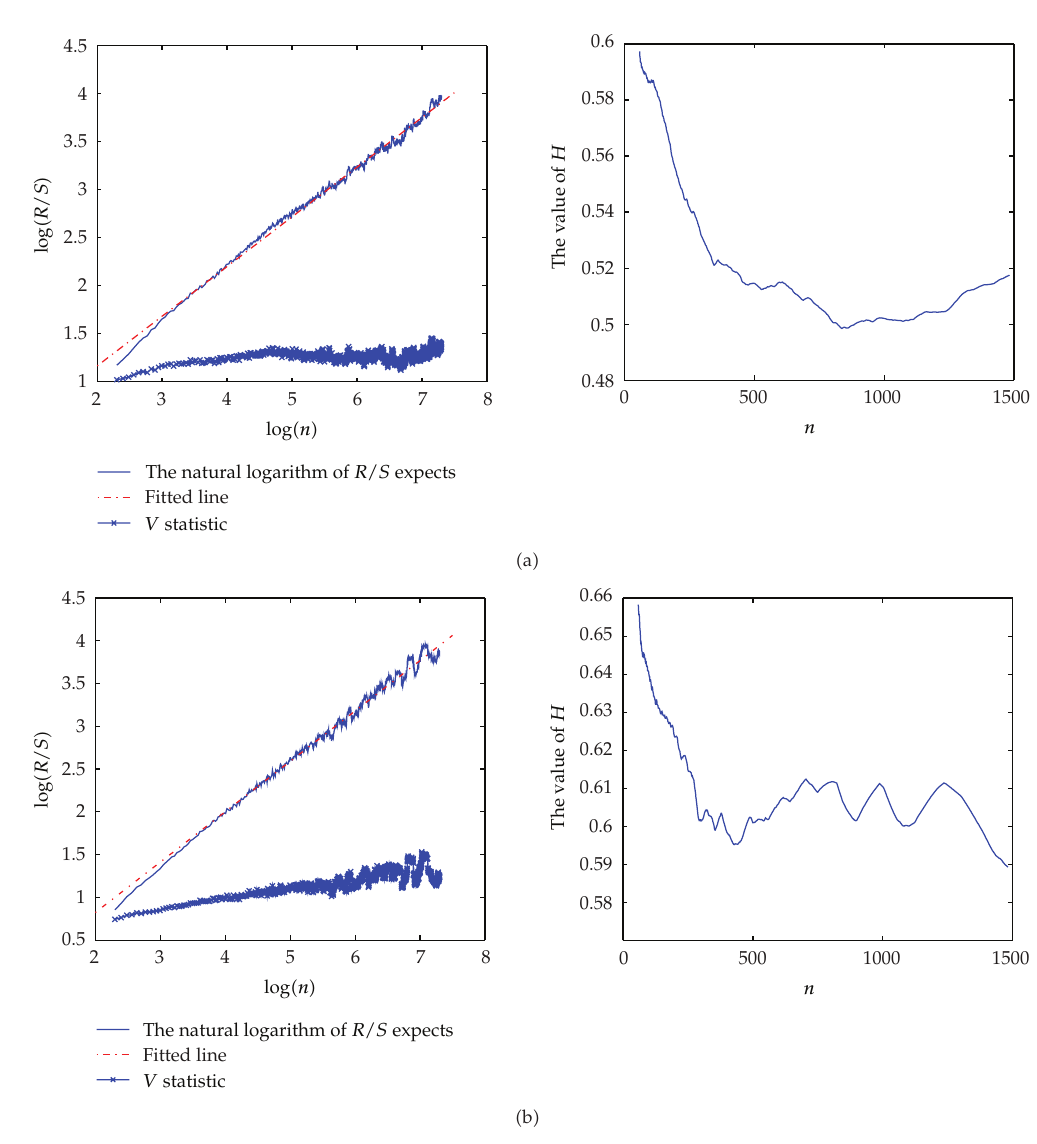
Figure 4: (cid:2) a (cid:5) The plots of modified R/S statistics and the fluctuation of exponent H for the price model. (cid:2) b (cid:5) The corresponding plots for the actual data from Hang Seng